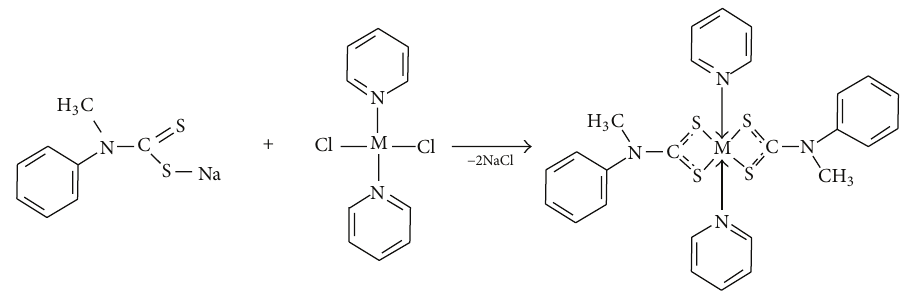
Scheme 2: Synthesis procedure.